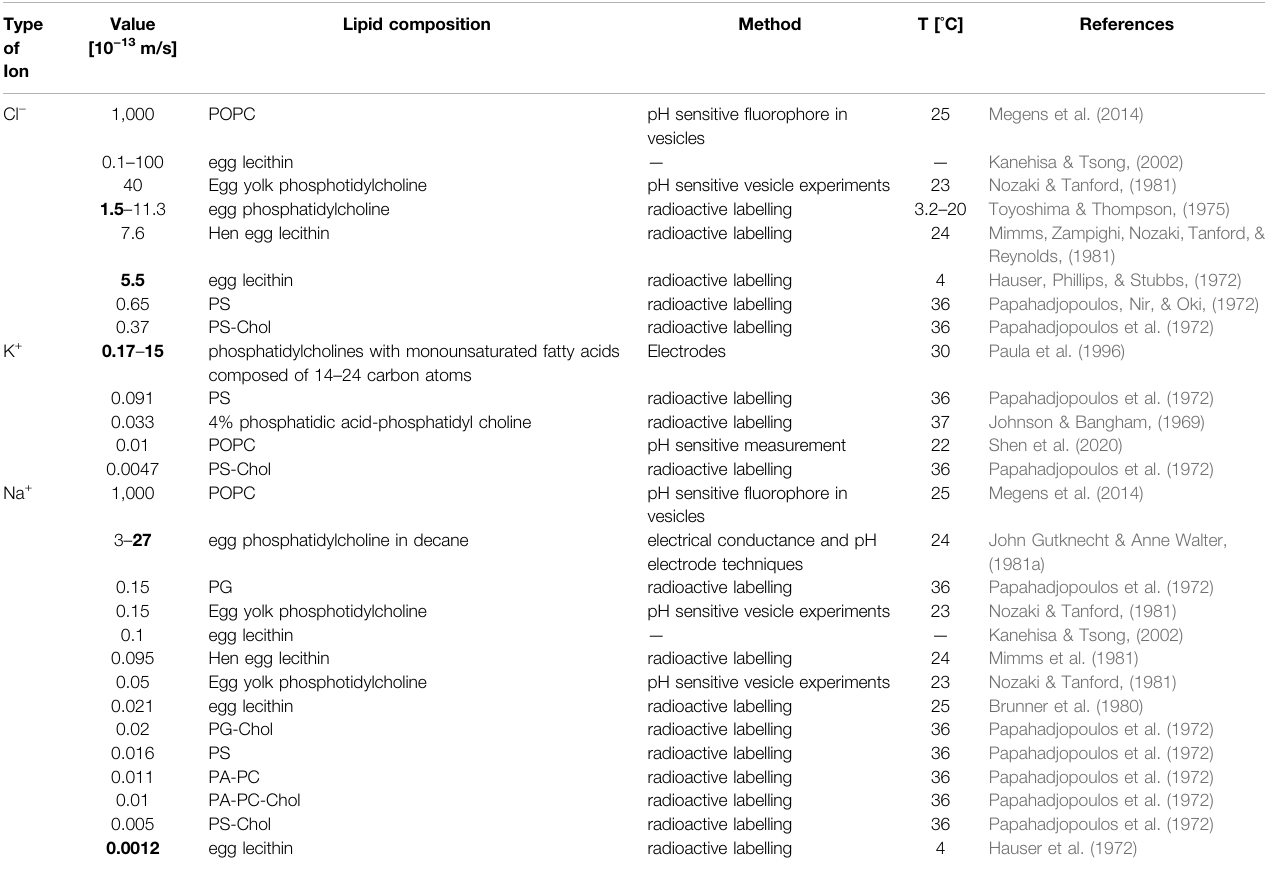
TABLE 1| Literature valuesfor passivemembranepermeabilities ofCl − ,K + , and Na + . Indicated arethe lipidcompositionand temperaturefor whichthe valuewasestimated and the method employed for the measurement. Bold values indicate for each ion the values for P max and P min chosen in the simulations. Type